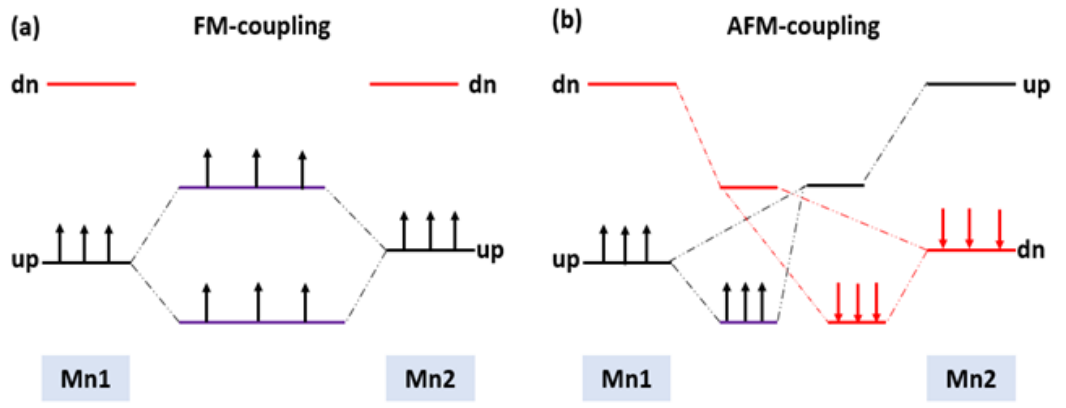
Figure 8. Schematic energy levels for two Mn interaction in the ( a ) FM and ( b ) AFM states.